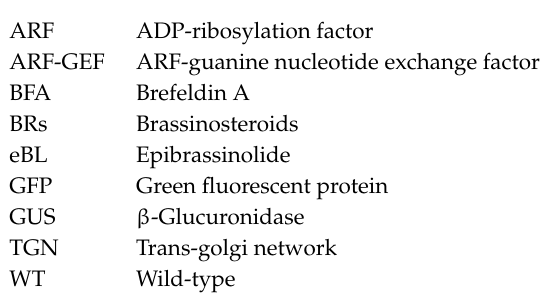
s1. Figure S1 Physical maps of BIG-subfamily ARF-GEF genes and the relative transcript levels in mutants. Figure S2. Functional redundancy between BIG5 and BIG3 in regulating plant growth. Figure S3 big3-1 big5-1 show a reduced sensitivity to eBL. Figure S4 BIG5 partially colocalizes with TGN marker VHA-a1-GFP and key residue within SEC7 domain determines the BFA sensitivity of ARF-GEFs. Figure S5 Expression patterns of BIG-subfamily ARF-GEF genes in young seedlings. Figure S6 big5-1 and big3-1 big5-1 mutants display a hypersensitive response to gravity stimulation. Figure S7 the negative gravitropic growth is suppressed by eBL but big5 exhibits a reduced sensitivity. Figure S8 big5-1 and big3-1 big5-1 display a delayed internalization of FM4-64 dyes. Figure S9 Genetic relationship analysis of BIG5 and BRI1 . Figure S10 Mutations in big3-1 big5-1 induce ectopic PIN1 and PIN2 subcellular localization. Table S1. Primers used in this study. Table S2. Detail of the key reagent and resource